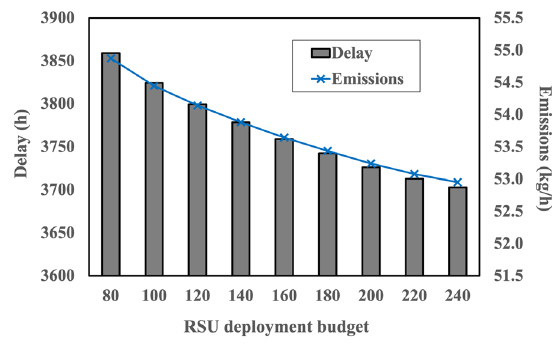
Fig. 4 Network delay and emissions under different deployment